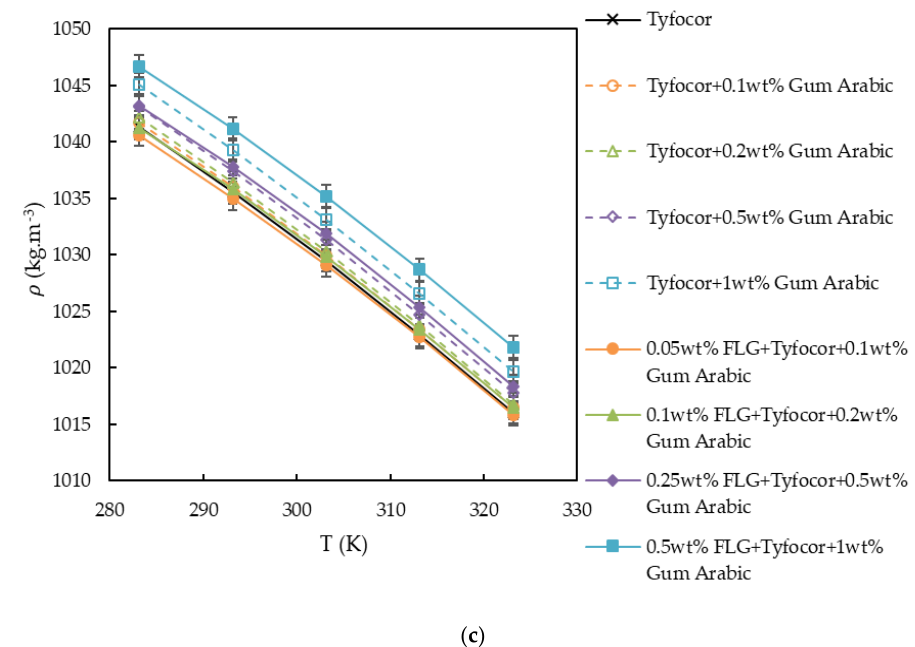
Figure 2. Density of FLG-based nanofluids and the corresponding base fluids against temperature